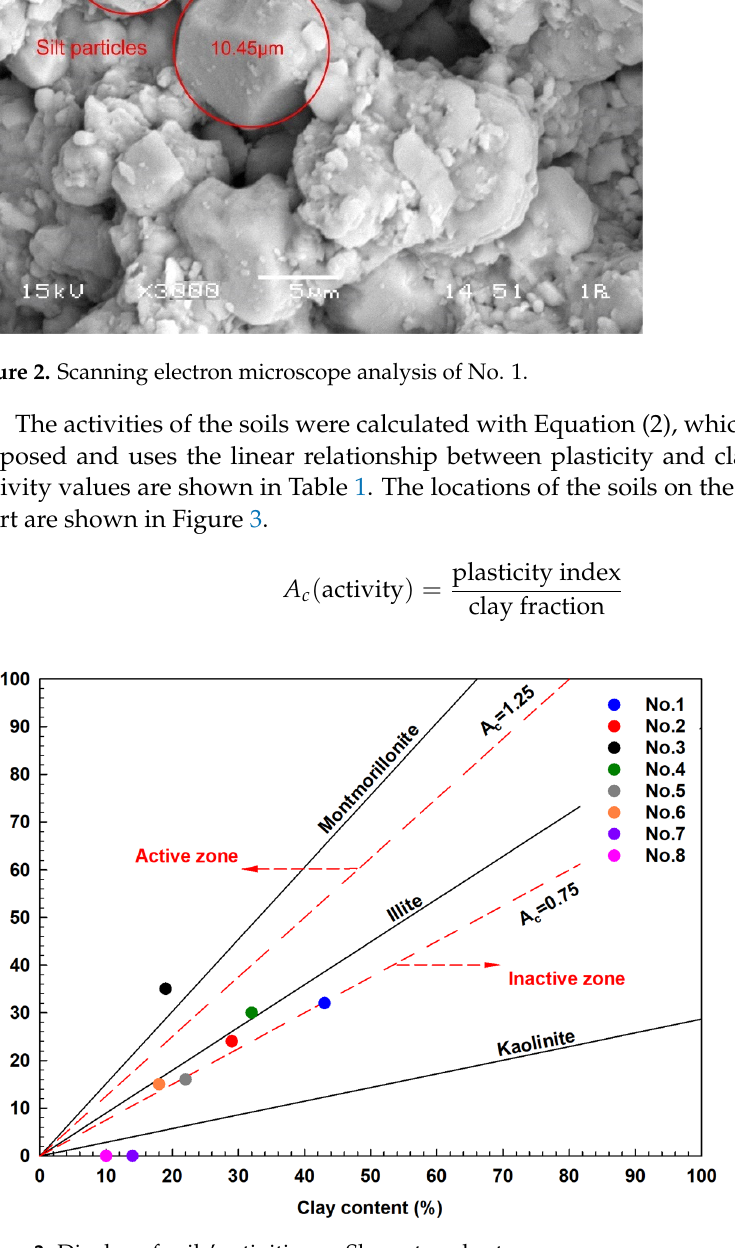
Figure 3. Display of soils’ activities on Skempton chart.